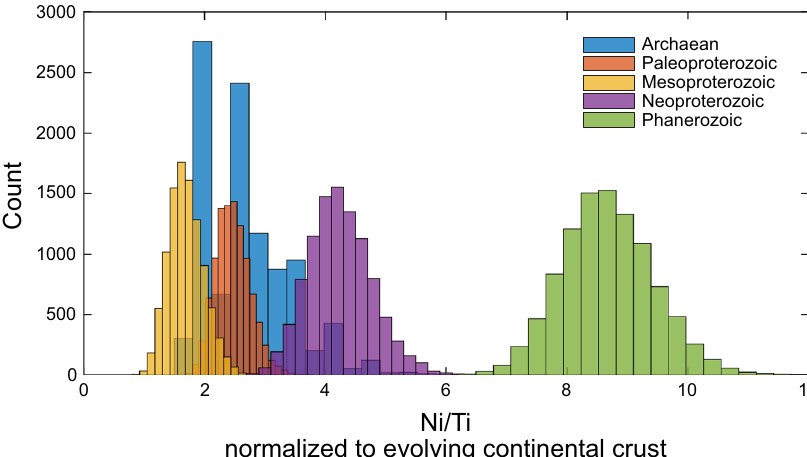
Fig. 5 Bootstrap resampled mean values from time-binned shale samples. Each group represents a time-binned subset of the shale database representing the Archaean (blue), Paleoproterozoic (orange), Mesoproterozoic (yellow), Neoproterozoic (purple), or Phanerozoic (green) with mean values of molar Ni/Ti, normalized to evolving crust 116 , being bootstrap resampled ( n = 10,000 for